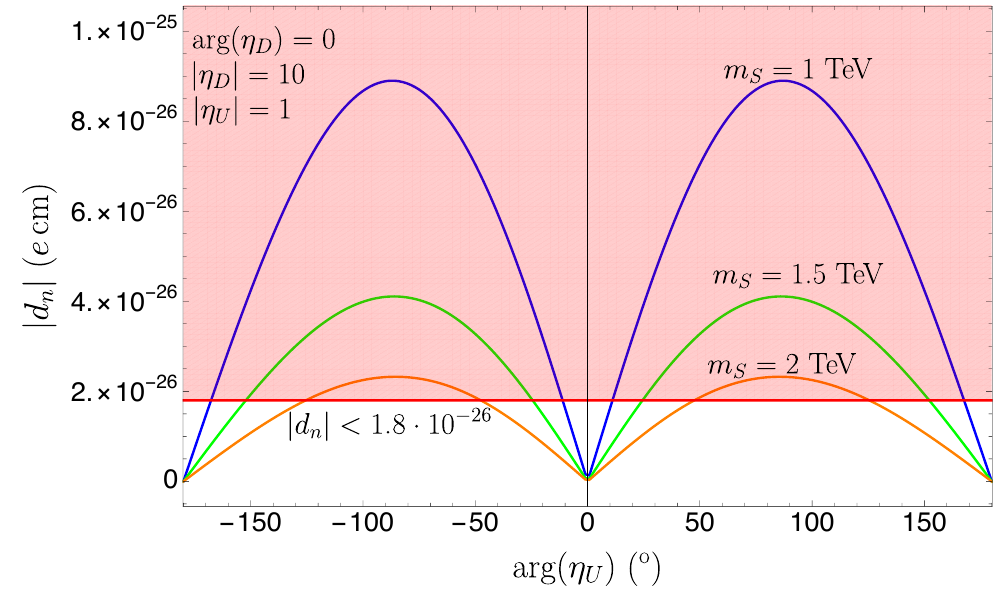
Figure 9 . Electric dipole moment of the neutron as a function of the complex phase of η U . The shaded region is excluded by the current experimental